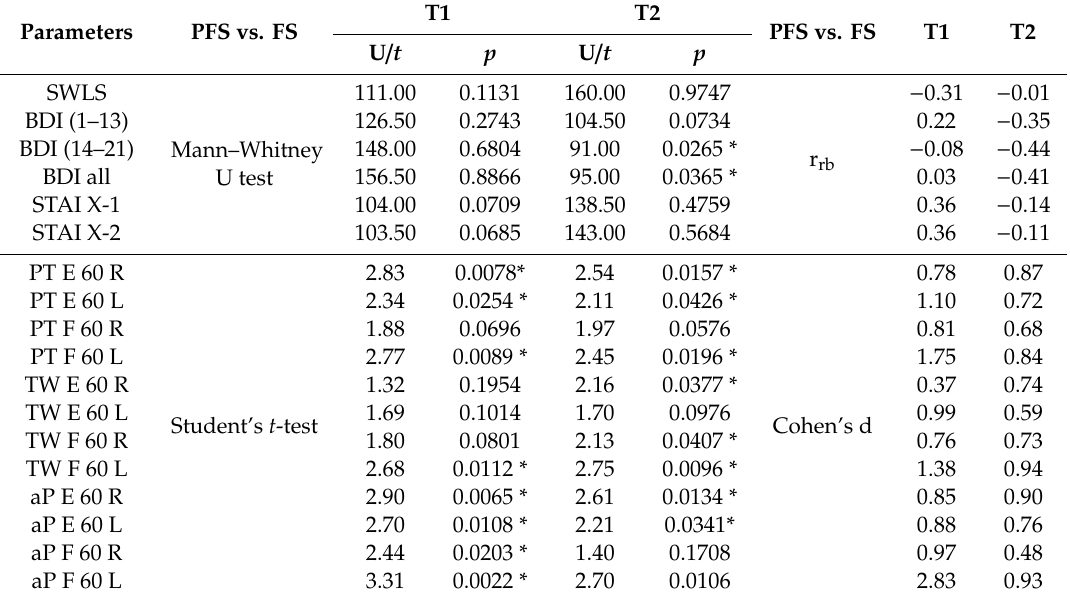
Table 5. Statistically significant di ff erences in the parameters between the FS group and PFS group in the initial (T1) and final (T2)